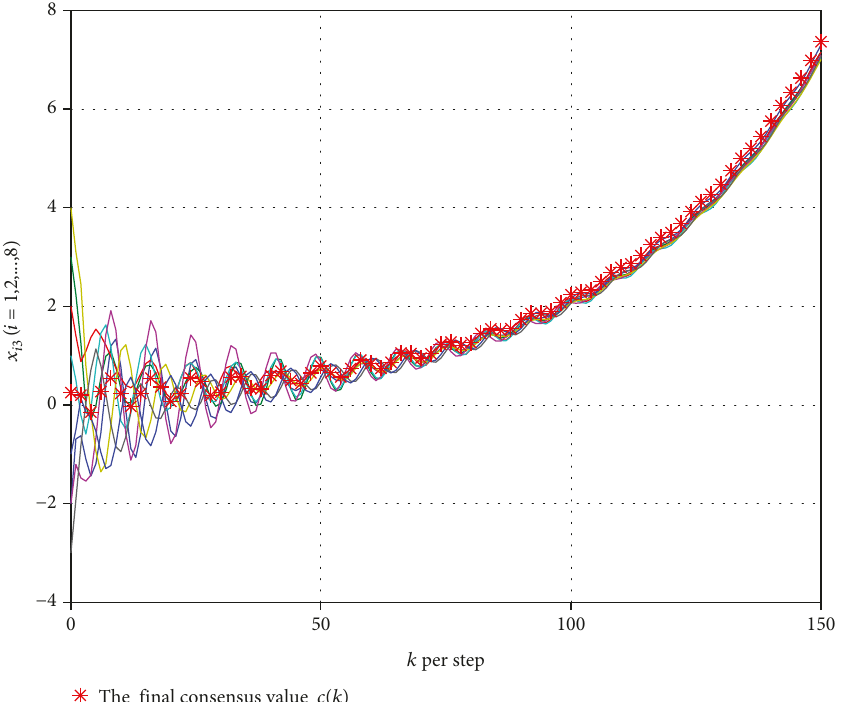
Figure 4: State 3 trajectories of swarm system